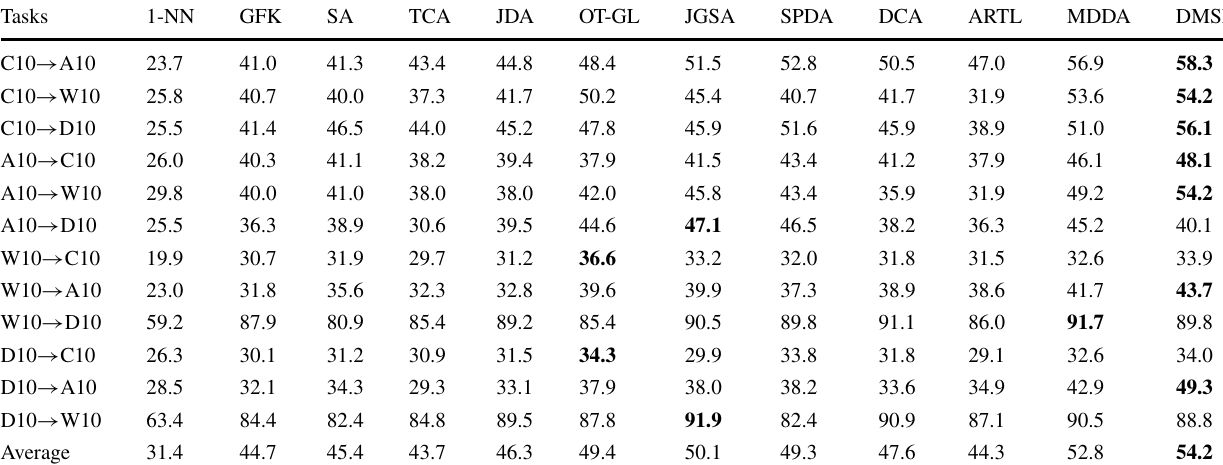
Table 2 Accuracy (%) on Office + Caltech (SURF) Tasks